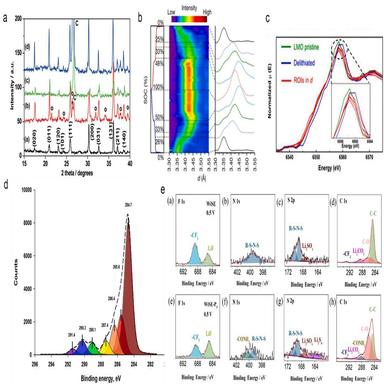
a. XRD patterns of LiCoPO4 (a) before and (b) after charge, (c) subsequently discharged, and (d) discharged after the 25th cycle in aqueous LiOH electrolyte. Peaks are indexed as a pure olivine structure. b. XRD patterns of the (0 0 m + 1) peak of the LBC–G composite obtained in situ during a charge–discharge cycle. The patterns were collected with high-energy X-ray radiation (wavelength of 0.1173 Å) in transmission geometry. Left, corresponding voltage profile. Right, two-dimensional contour